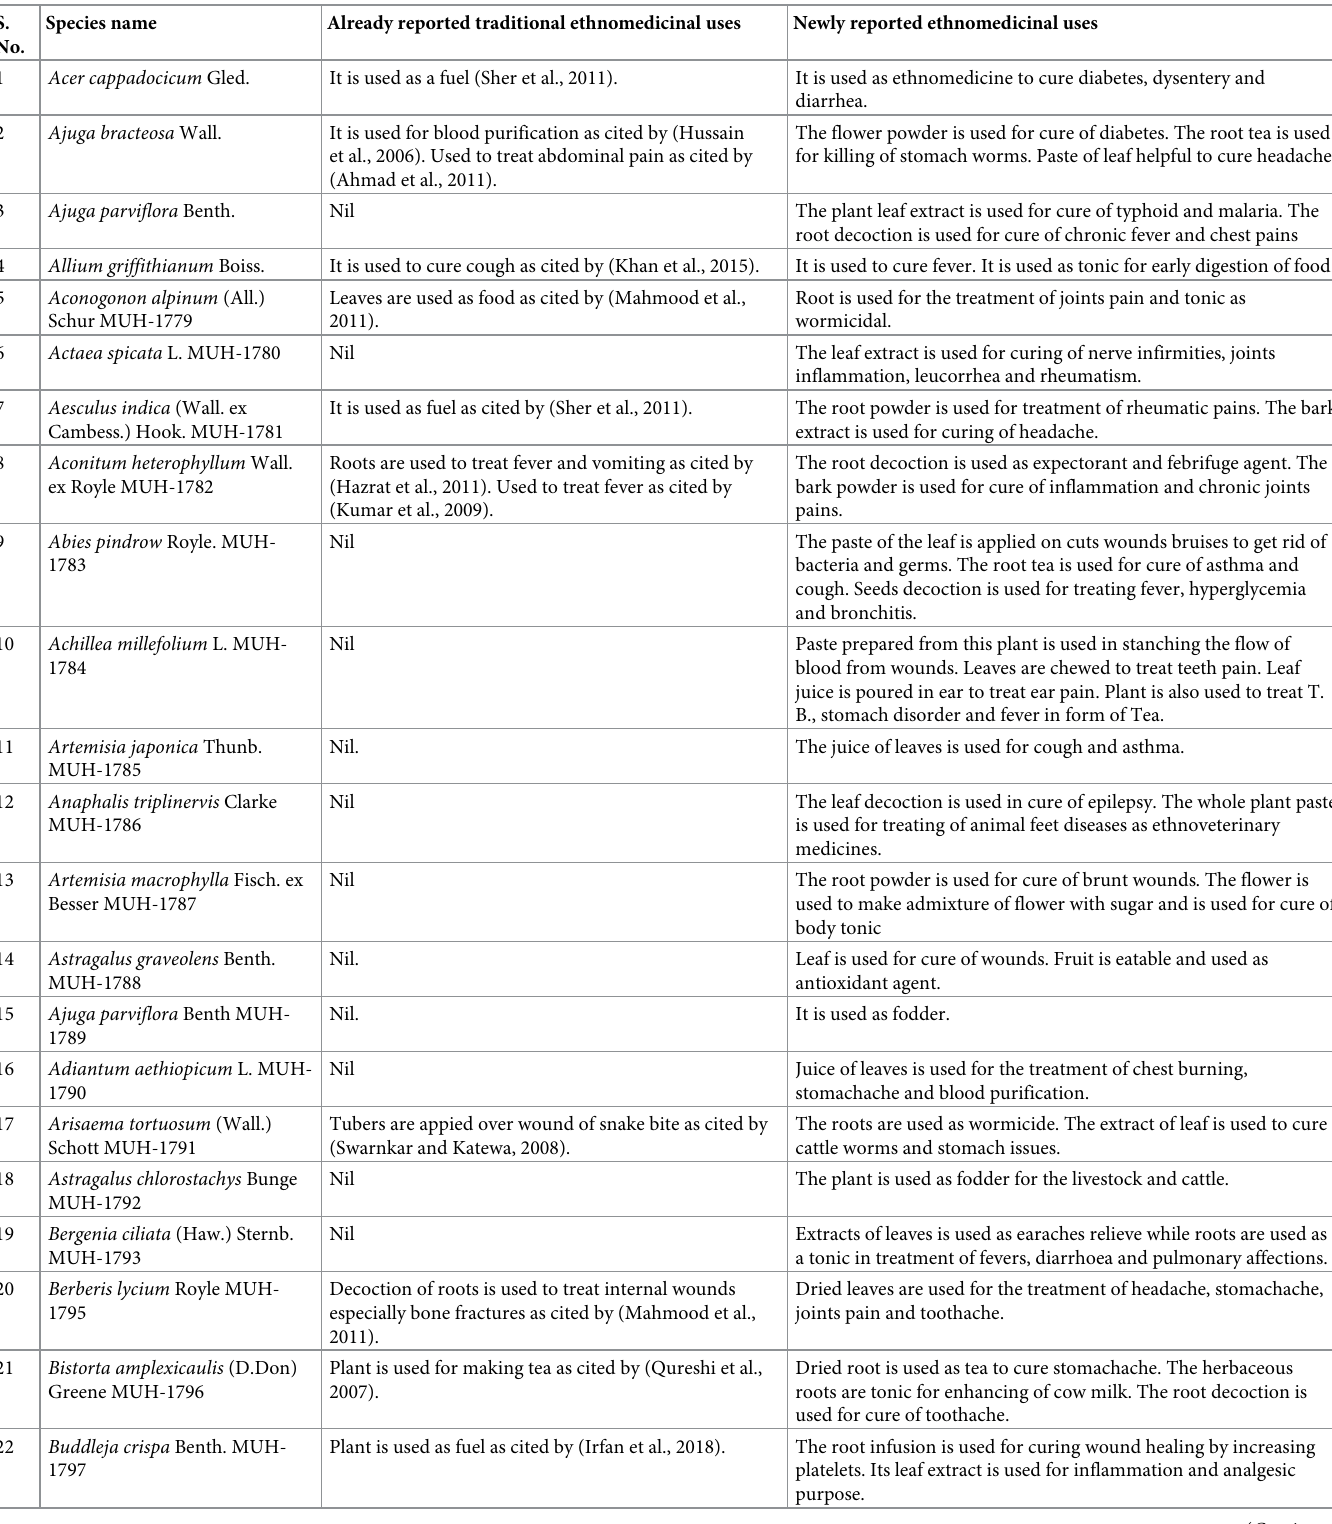
Table 12. Novelty aspect analysis by comparing of ethnobotanical and ethnomedicinal uses of indigenous plants from Dawarian and Rati Gali, AJK (Pakistan). S. Species No.